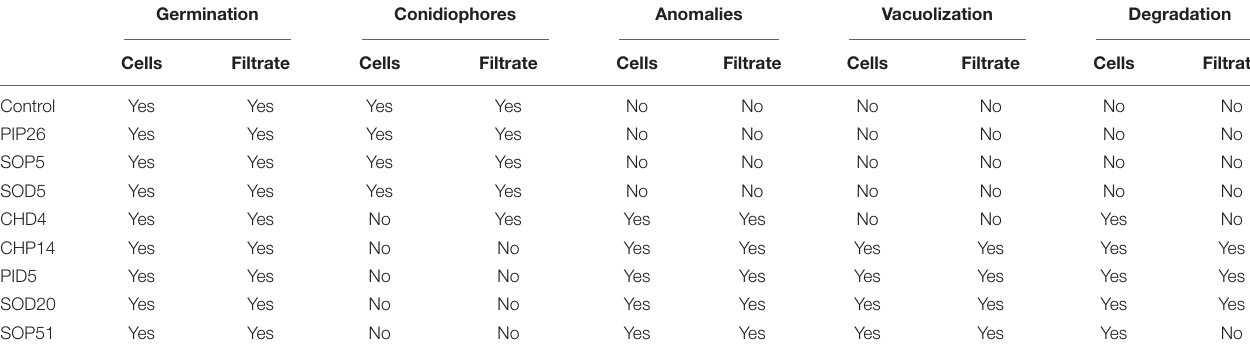
TABLE 1 | Presence or absence of different phenotypes in spores exposed to bacterial cells or their spent medium (filtrate) for 24 h. Germination Conidiophores